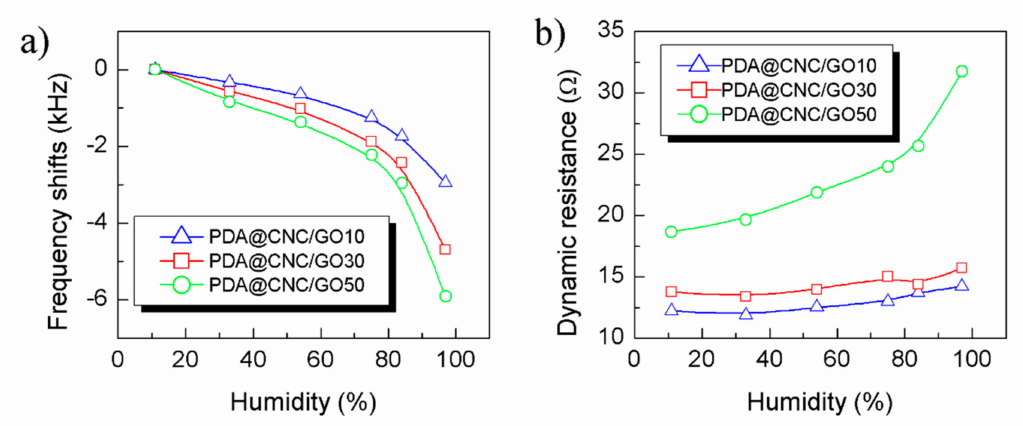
Figure 7. The e ff ect of the PDA@CNC content on the performance of PDA@CNC / GO nanocomposite-coated QCM humidity sensor. ( a ) Frequency shifts and ( b ) dynamic resistance as a function of RH.